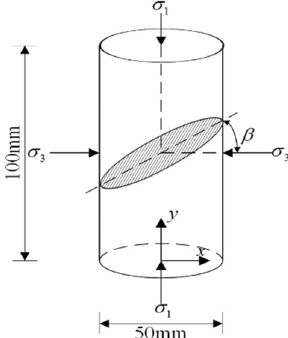
Figure 2. Definition of joint dip angle